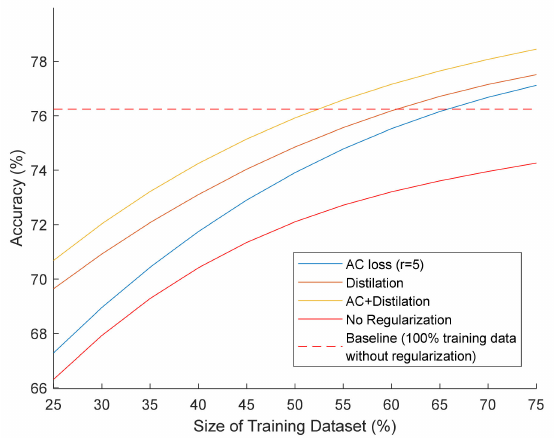
Figure 4. Validation accuracy vs. training data availability for Simple CNN on CIFAR10. Comparison between regular training and different regularization